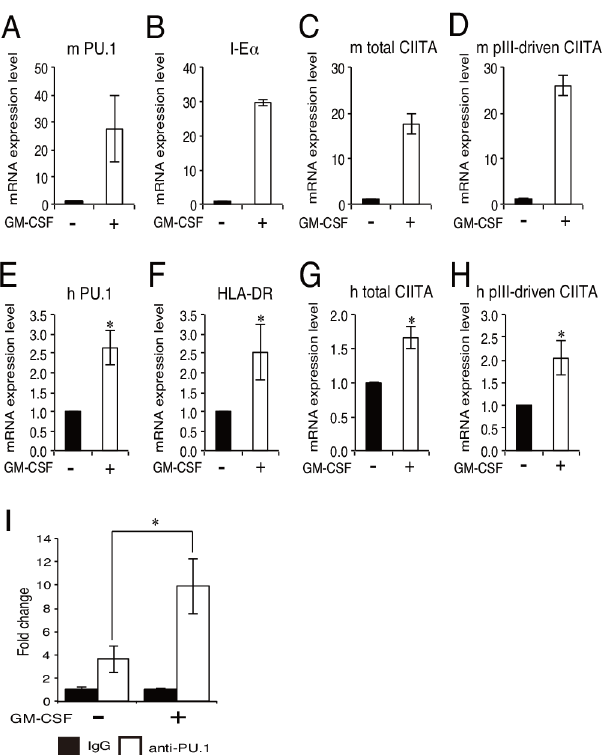
Fig 5. Effect of GM-CSF stimulation on the expression of PU.1, CIITA, and MHC class II, and on the recruitment of PU.1 to the pIII. A-H. Quantitative real-time PCR analysis of the mRNA expression of PU.1 (A, E), MHC class II (B, F), total CIITA (C, G), and CIITA driven by pIII (D, H) in mouse splenic pDCs (A-D) or CAL-1 cells (E-H) with (+) or without (-) GM-CSF stimulation. Mouse pDCs and CAL-1 cells were stimulated with 20 ng/ml mGM-CSF for 24h and 10 ng/ml hGM-CSF for 72h, respectively. I. The amount of PU.1 binding to the pIII in GM-CSF-stimulated CAL-1 cells (+) or control cells (-) was determined by a ChIP assay. Binding level of PU.1 (open bar) is expressed as fold change against that of control IgG (closed bar). In E-I, data represent means ± SEMs of three independent experiments performed with duplicate samples. In A-E, the results are expressed as means ± SEMs of triplicate samples, and similar result was obtained in another experiment. * , p <